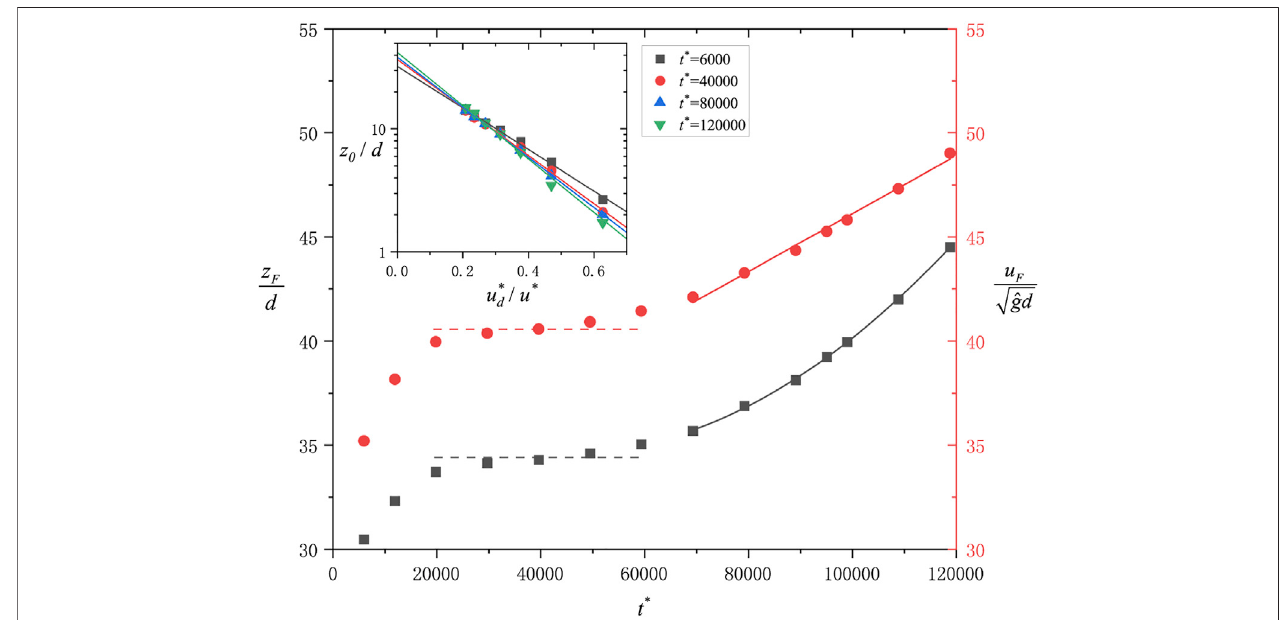
FIGURE 15 | Time evolution on the height z F of the focal point and the wind velocity u F at this point. The inset shows the relationship between z 0 and u * at different times.